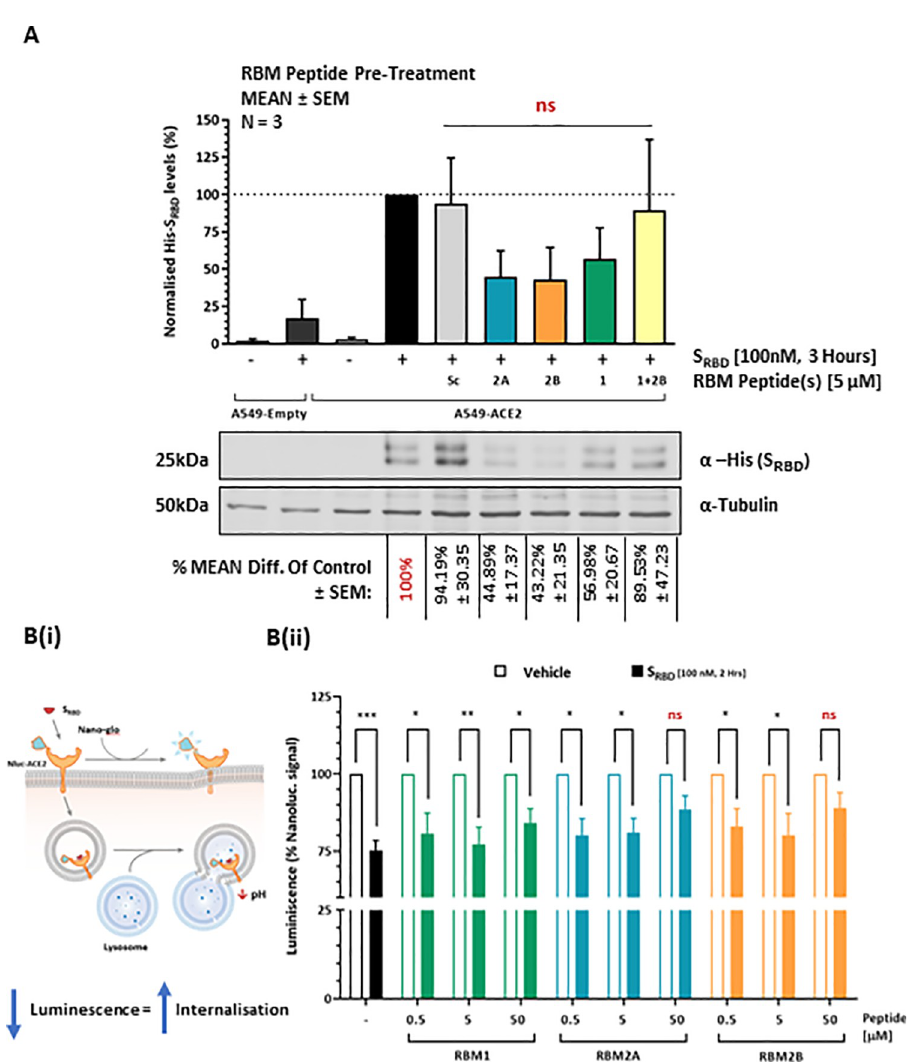
Fig 5. S RBD internalisation in human ACE2 overexpressing human cell lines. (A) western immunoblot detection of internalised S RBD protein in ACE2 overexpressing (stable) A549 cells following 30 minutes pre-treatment with (i) vehicle only (lane 4), (ii) RBM2A-Sc (lane 5), (iii) RBM2A (lane 6), (iv) RBM2B (lane 7), (v) RBM1 (lane 8), RBM1 + RBM2B (lane 9). (B) Changes to S RBD mediated internalisation in transiently overexpressing ACE2 (luciferase) HEK293T cells were measured following co-treatment with S RBD (100 nM) and (i) RBM1, (ii) RBM2A, (iii) RBM2B peptides (0.5, 5 and 50 μ M). Levels of internalised S RBD measured as % difference of vehicle only control. All data represented as MEAN ± SEM, N = 3 independent experiments. � P < 0.05, �� P < 0.01, ��� P < 0.001, n.s. not